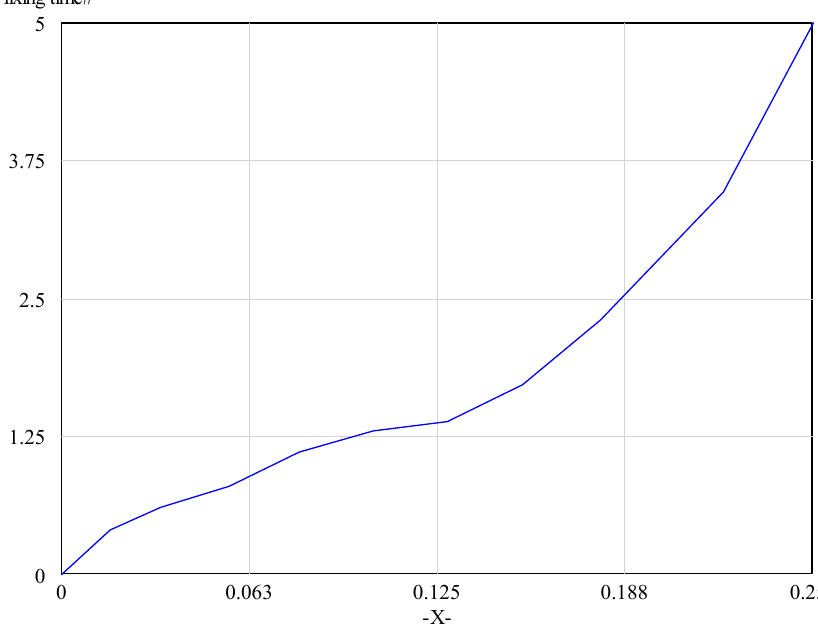
Figure A1. Relationship between fixing time and size of extreme event.